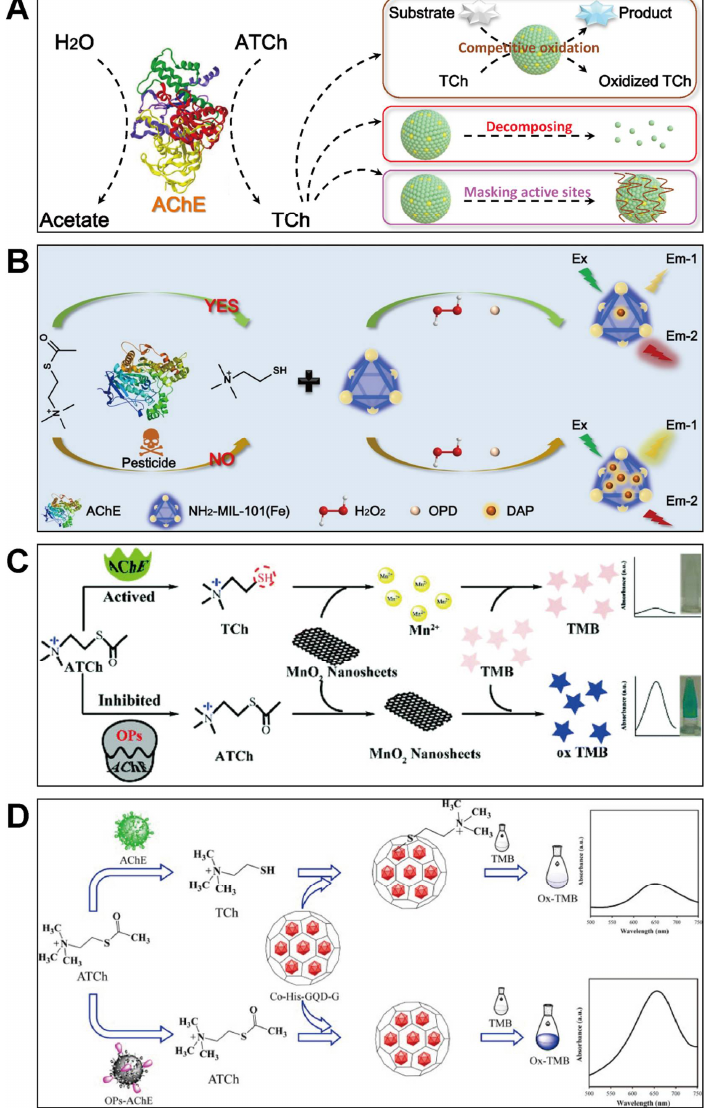
Figure 3. ( A ) explains possible effects of TCh generated from AChE catalysis on nanozyme sensing systems; ( B ) presents design of multifunctional NH 2 -MIL-101(Fe) for the ratiometric fluorescence determination of pesticides (reprinted with permission from [31], Copyright 2021, Elsevier); ( C ) illus- trates biosensing of OPs via generated TCh decomposing oxidase-like MnO 2 nanosheets (reprinted with permission from [72], Copyright 2009, Royal Society of Chemistry); ( D ) shows that TCh gener- ated from AChE catalysis can mask active sites of Co-His-GOD-G for OPs analysis (reprinted with permission from [73], Copyright 2021,